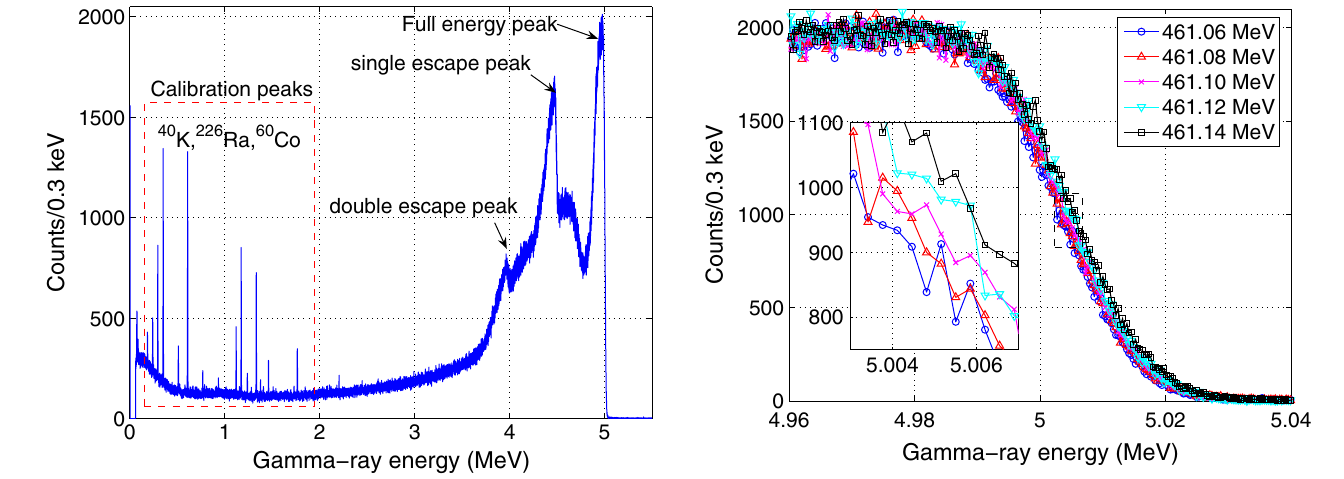
FIG. 8. (Color) A typical HI (cid:1) S beam spectrum measured by a large volume 123% efficiency HPGe detector. The radiation sources of 226 Ra and 60 Co as well as the nature background from 40 K are used in the real time for the detector energy calibration.